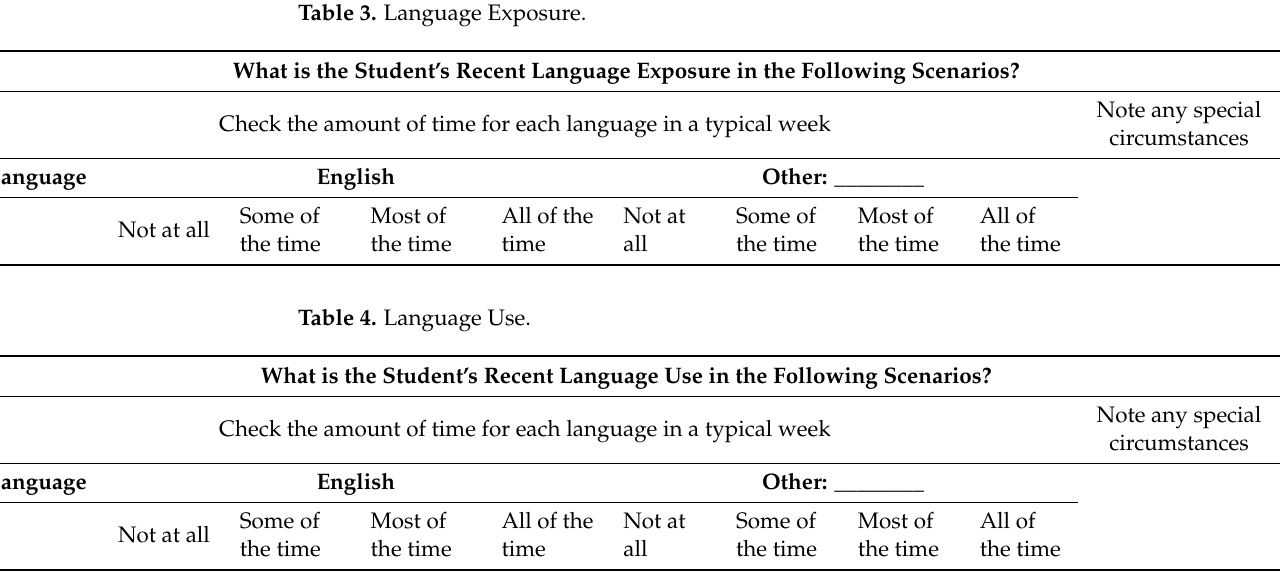
Table 3. Language Exposure.